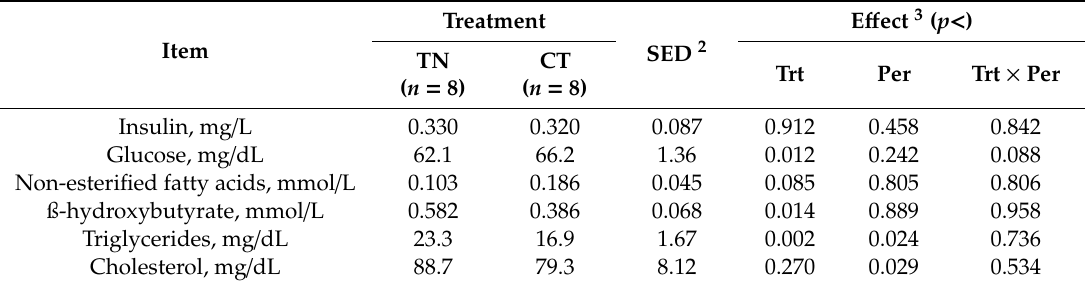
Table 4. Plasma insulin and metabolites measured in dairy goats under thermoneutral (TN, 15 to 20 ◦ C) or cold temperature (CT, − 3 to 6 ◦ C) conditions 1 .